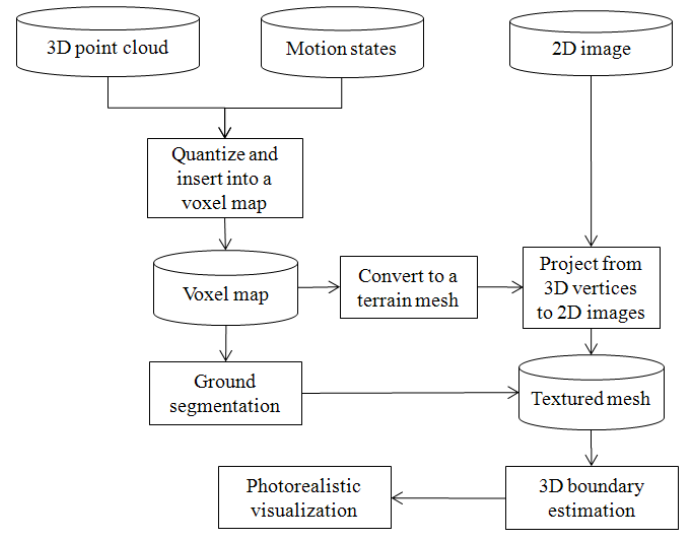
Figure 2. Framework for terrain modeling and photorealistic visualization using ground segmentation and 3D boundary